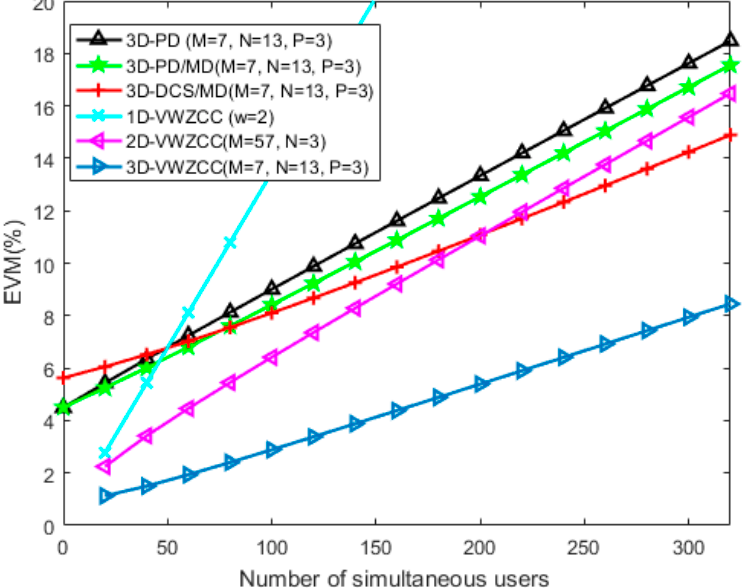
Figure 13. EVM versus number of simultaneous users when effective source power P sr = − 10 dBm and data rate R b = 1.25